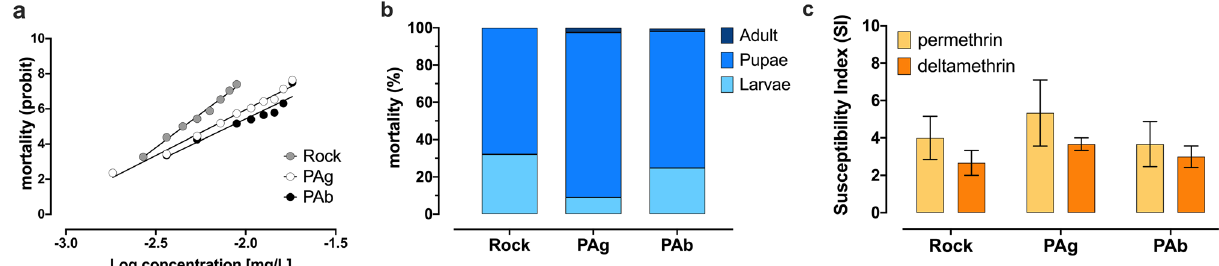
Figure 1. Larvicide bioassays with Aedes aegypti and Aedes albopictus from Lahore, Pakistan. ( a ) Dose– response bioassay to the organophosphate temephos, with mortality evaluated after 24 h of exposure. ( b ) Proportional mortality of each life stage to the diagnostic dose of the IGR pyriproxyfen. The adult emergence inhibition (AEI) was 100% in all experimental cases. ( c ) Susceptibility index (SI) average (with SEM error bars) for the pyrethroids permethrin and deltamethrin. The higher the SI, the less susceptible the population. Ae. aegypti Rockefeller strain (Rock) was used as a reference in all these larvicide bioassays.